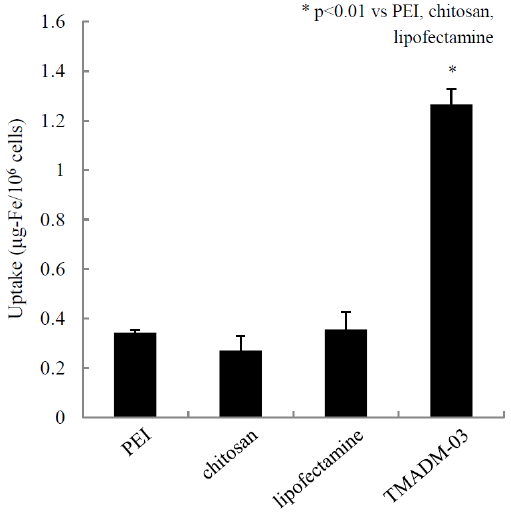
Figure 6. The labeling efficiency of TMADM-03 compared with other compounds. TMADM-03 and nanoparticles with PEI, chitosan, and cationic lipid (lipofectamine) were evaluated for their labeling efficiency. The conditions used for cell labeling was a 1 hr incubation at 37 u C in culture medium containing 15% FBS. The concentration of TMADM-03 was 150 m g-Fe/mL, and the concentrations of the nanopar- ticles with other compounds were the same as in the previous reports